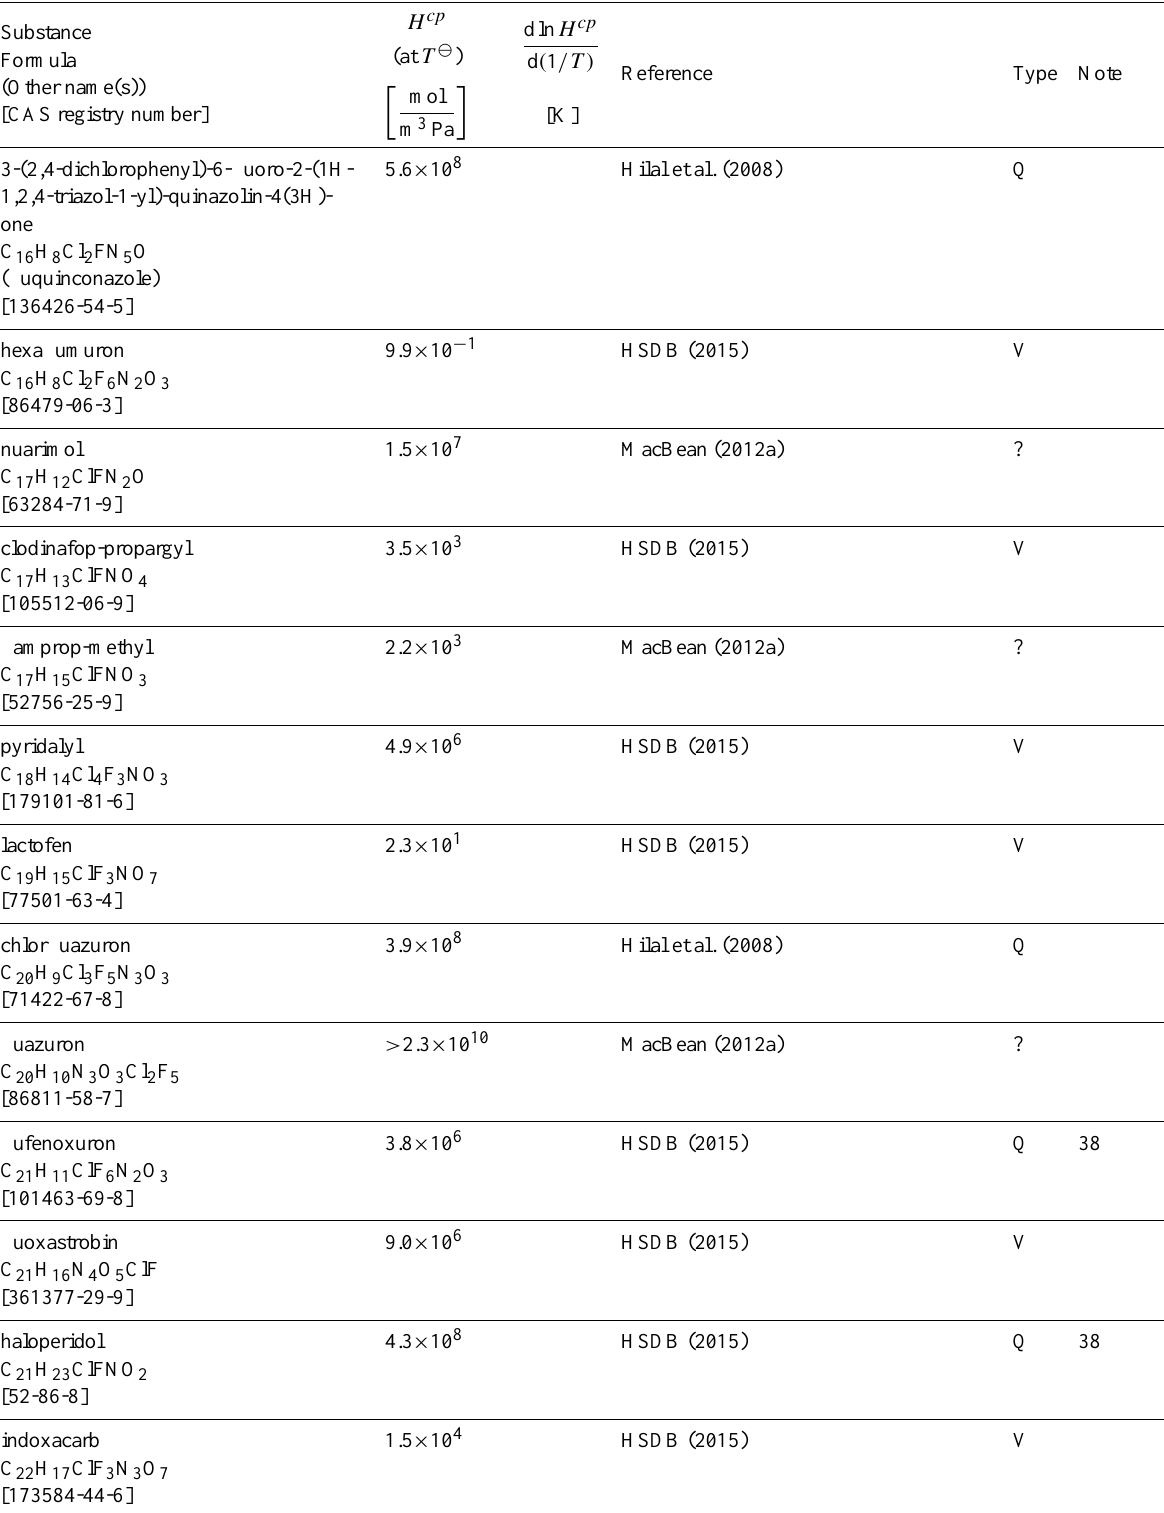
Table 6: Henry’s law constants for water as solvent